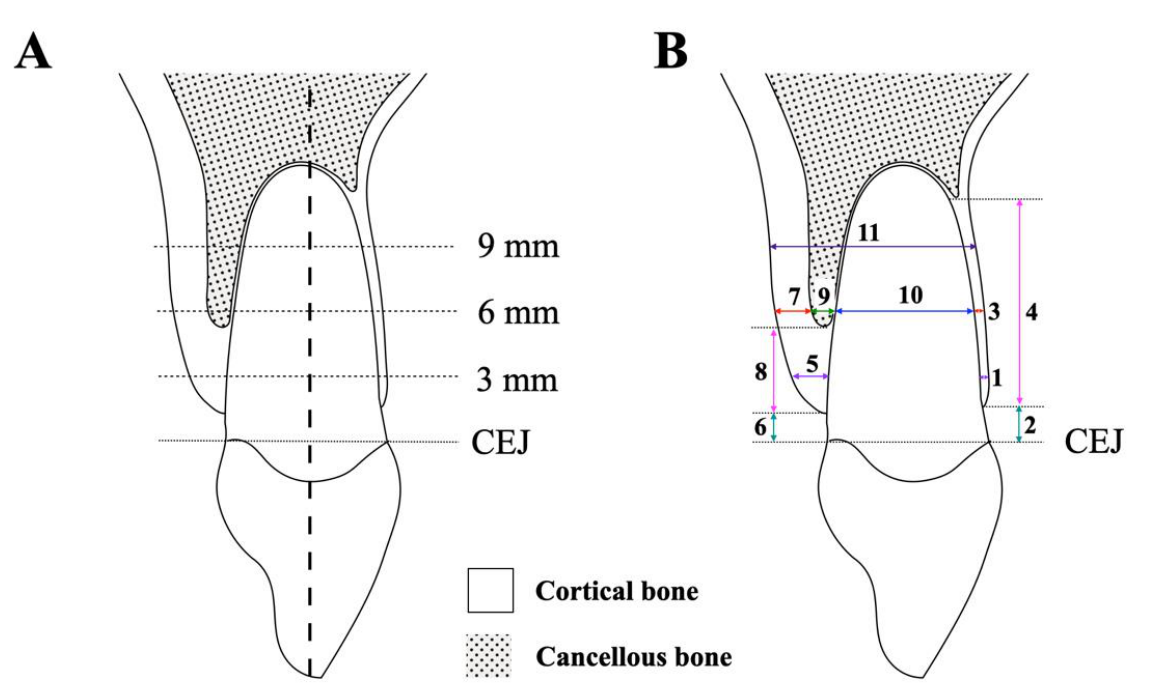
Figure 1. Cephalometric measurements . ( A ) The vertical references: the measurements perpendicular to the tooth’s long axis at 3, 6, and 9 mm apical to the CEJ. ( B ) Cephalometric measurements of (1) to (4) on labial side: (1) labial alveolar bone thickness, (2) labial alveolar bone height, (3) labial cortical bone thickness, (4) labial cortical bone height. Cephalometric parameters of (5) to (9) on palatal side: (5) palatal alveolar bone thickness, (6) palatal alveolar bone height, (7) palatal cortical bone thickness, (8) palatal cortical bone height, (9) palatal cancellous bone thickness, (10) root diameter, and (11) total root-bone thickness.